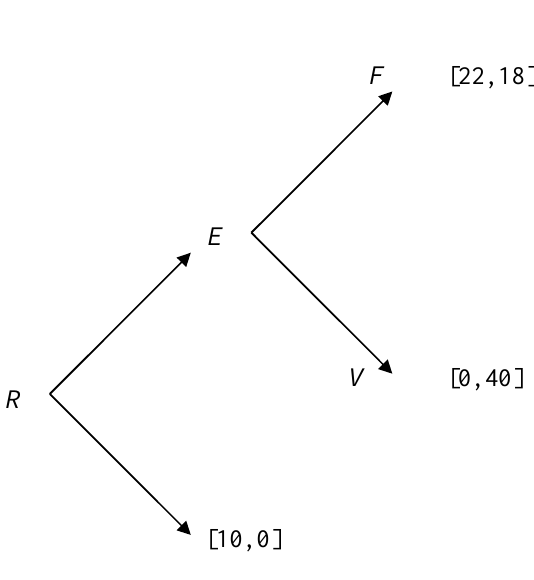
Figure 1: Structure of the trust game and